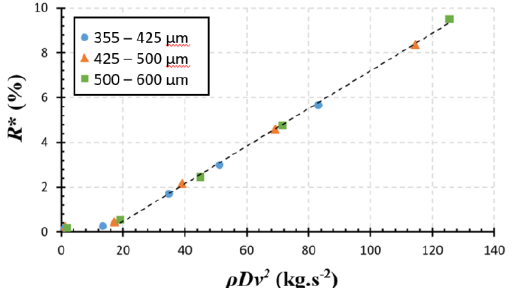
Fig. 4. Breakage of paracetamol crystals as a function of size and impact velocity, extracted from the work of Dogbe [4].